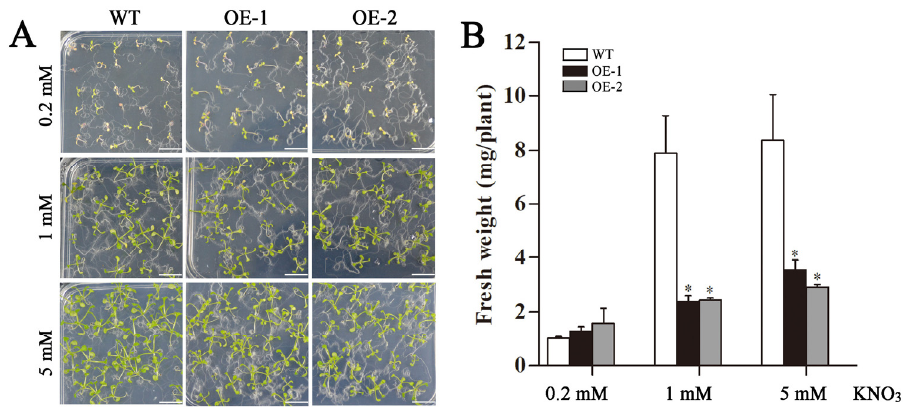
Figure 4. Analysis of fresh weight in WT and transgenic Arabidopsis hosting CsLBD39 gene under KNO 3 treatment. ( A ) The phenotypes of the 15-day-old plants under different KNO 3 conditions. Bar = 1 cm. ( B ) Fresh weight of the 15-day-old plants under different KNO 3 conditions. The data are expressed as mean ± standard deviation of three biological replicates ( n = 3). Asterisks (*) indicate that the value is significant difference compared to the WT (* p < 0.05).